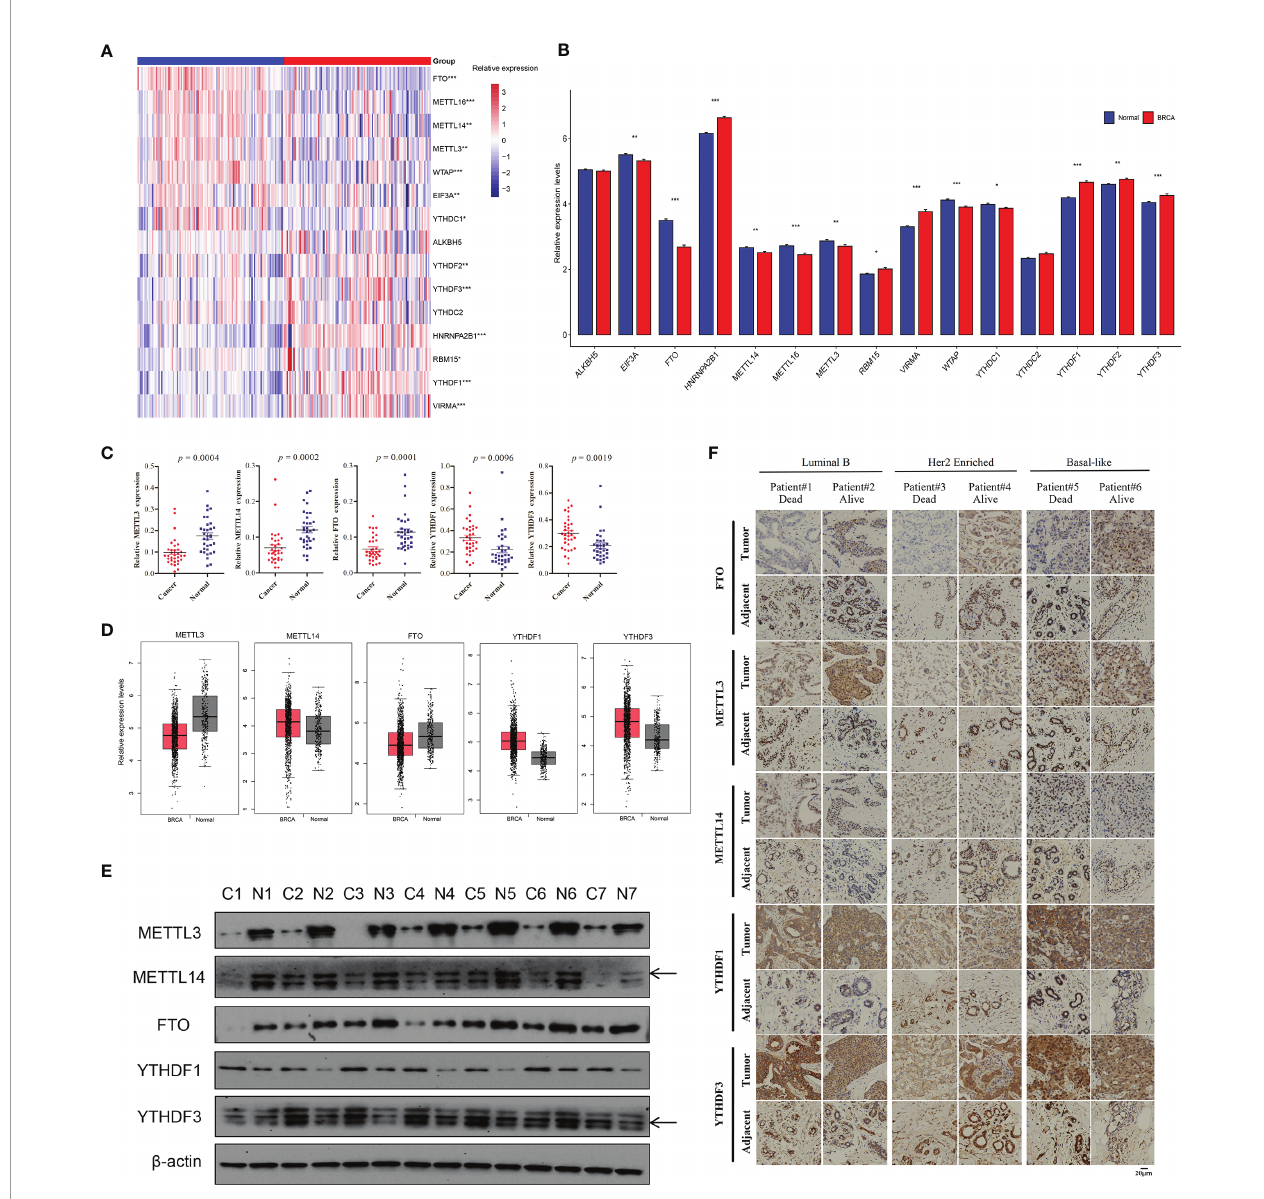
FIGURE 2 | Relative mRNA and protein expression levels of m 6 A regulators in breast cancer. (A) The heatmap of 15 m 6 A regulators ’ expression levels in 112 paired breast cancer samples; red, breast cancer; blue, adjacent normal samples. (B) The barplot of relative expression levels of m 6 A regulators in paired samples; BRCA, breast cancer. (C) The qPCR validation results of fi ve signi fi cantly differential m 6 A regulators in 33 paired clinical samples of breast cancer patients. (D) The relative expression levels of fi ve m 6 A regulators in tumor and normal samples based on GEPIA analysis, p < 0.01. (E) The western blot results of fi ve m 6 A regulators in seven paired tumor and adjacent samples, and b -actin was used as endogenous control. (F) The IHC of fi ve m 6 A regulators in six patients with different molecular subtypes and survival state. The asterisks represented the statistical p-value, *p < 0.05, **p < 0.01, ***p <